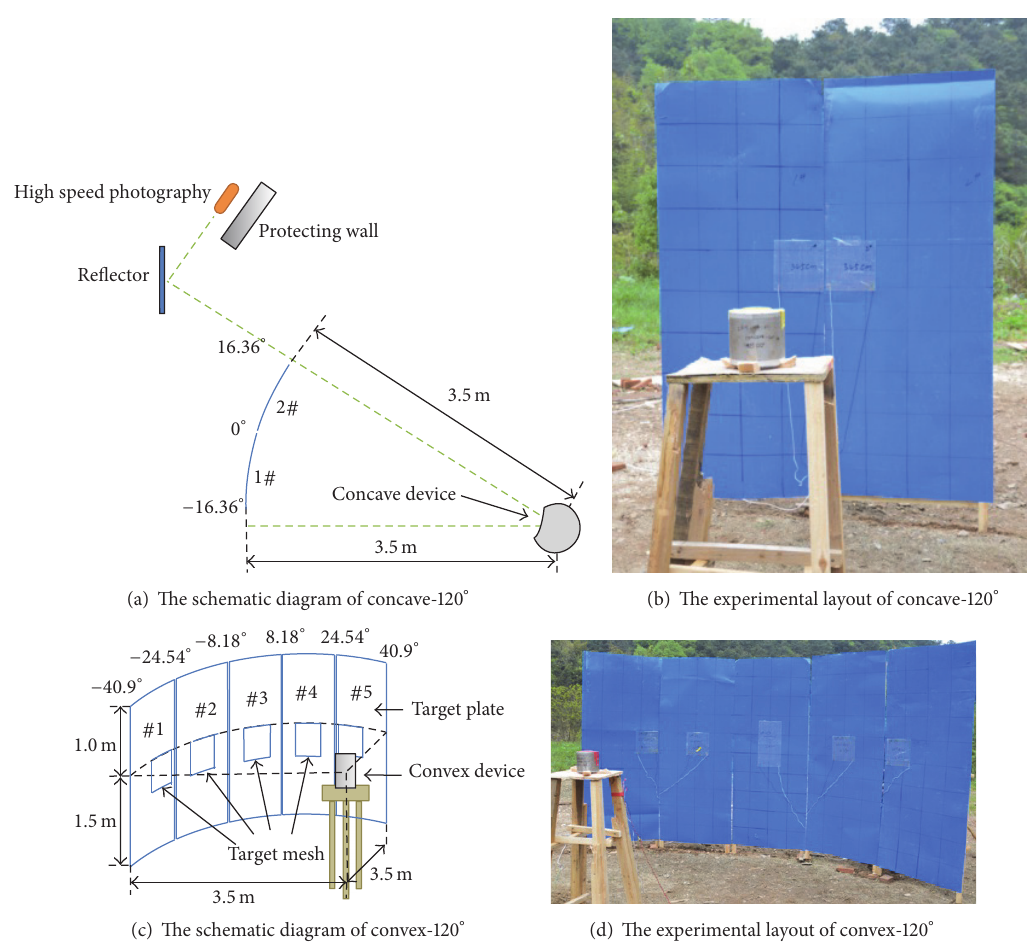
Figure 3: Experimental setups of the asymmetric